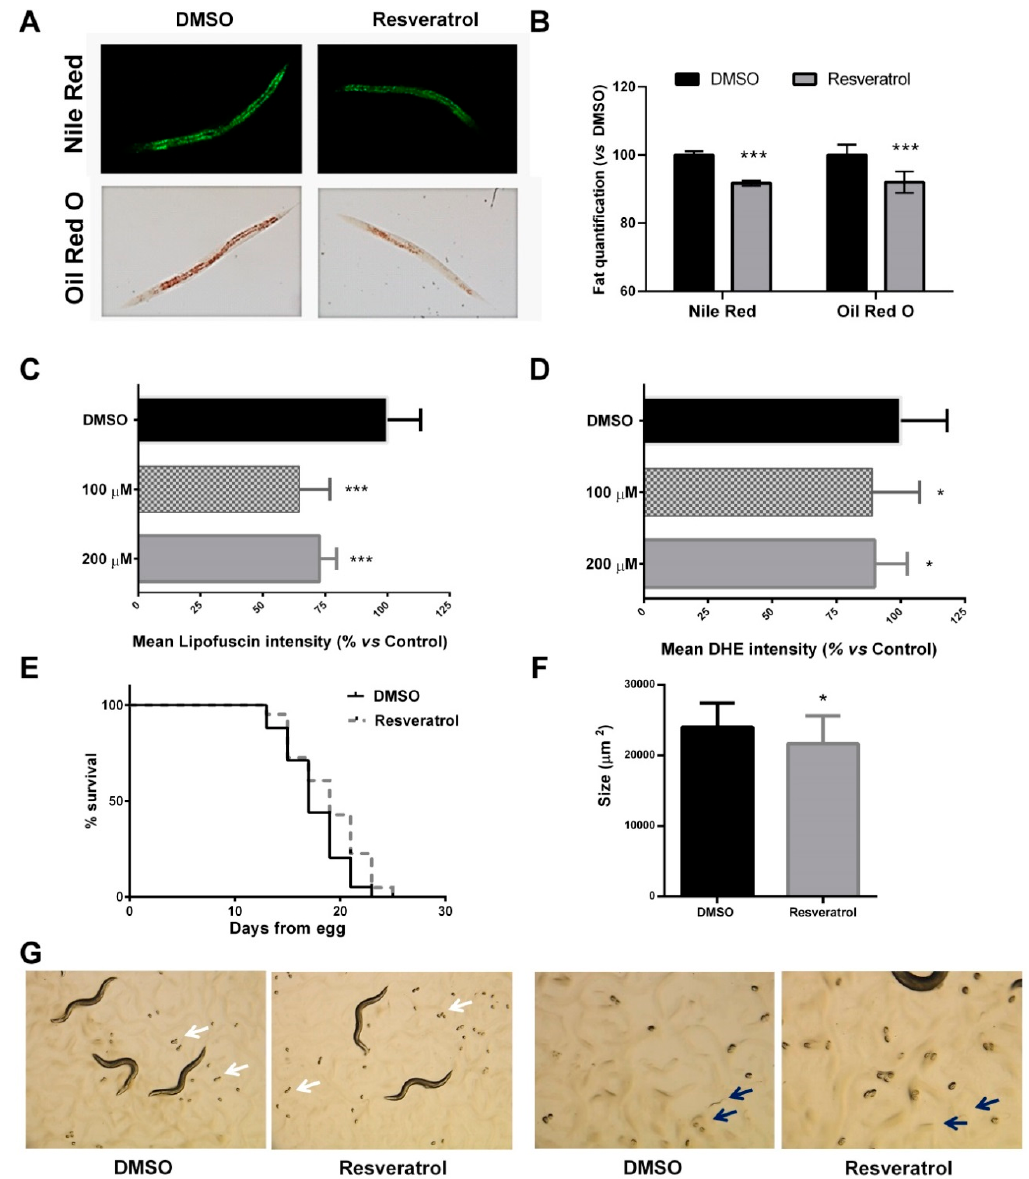
Figure 2. Resveratrol increases C. elegans healthspan. ( A ) Nile Red and Oil Red O staining of DMSO- and resveratrol-treated worms. ( B ) Nile Red and Oil Red O quantification of DMSO- and resveratrol-treated worms (100 µM). The results are expressed as the mean ± SD relative to DMSO-treated worms. Significance refers to the effect of resveratrol with respect to DMSO control worms (Student’s t -Test, *** p < 0.001). ( C ) Quantification of lipofuscin aging pigment of resveratrol-treated worms compared to DMSO control worms (mean ± SD relative to DMSO-treated worms). Significance refers to the effect of resveratrol with respect to DMSO control worms (ANOVA followed by LSD test, *** p < 0.001). ( D ) Quantification of the ROS production (measured by DHE) in resveratrol-treated worms compared to DMSO control worms (mean ± SD relative to DMSO treated worms. Significance refers to the effect of resveratrol with respect to DMSO control worms (ANOVA followed by LSD test, * p < 0.05). ( E ) Lifespan analysis of resveratrol-treated worms compared to DMSO control worms. ( F ) Size of the treated- and untreated worms on day 1 of adulthood. Significance refers to the effect of resveratrol with respect to DMSO control worms (Student’s t -Test, * p < 0.05) ( G ) Microscope observation of the presence of eggs (white arrows) and L1 larvae (blue arrows) in both DMSO- and resveratrol-supplemented plates.